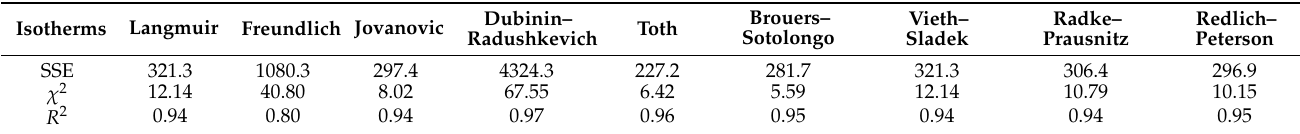
Table 4. Results of the curve fitting for isotherm models.